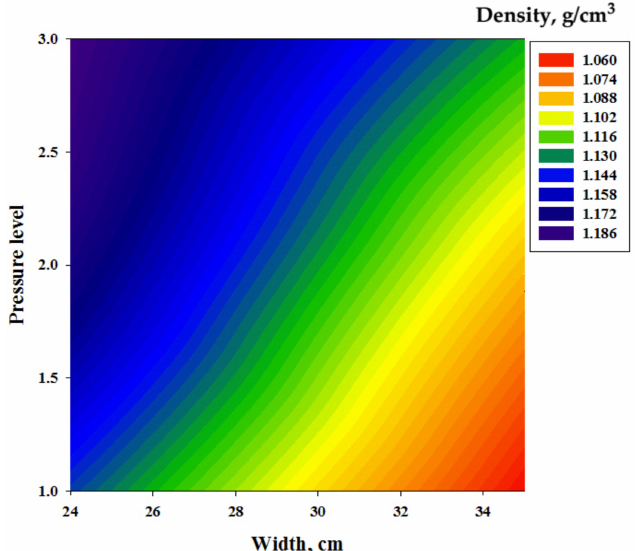
Figure 13. Three-dimensional surface curve of the main effect of tire type pressure and tire pressure on the soil bulk density of the